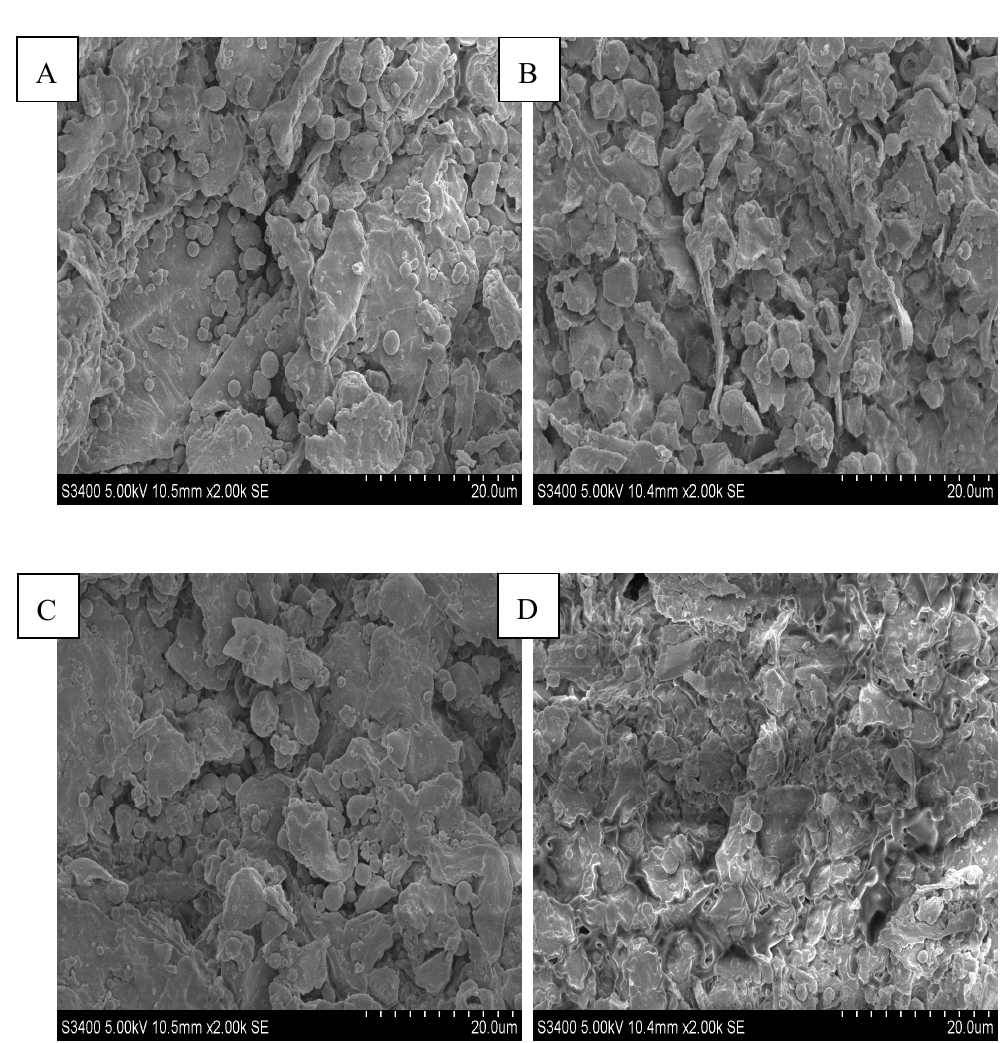
Figure 1. Scanning electron microscopy images of rice bran dietary fiber at different treatment stages ( A ) defatted rice bran, ( B ) rice bran dietary fiber, ( C ) cellulase enzymatic treatment rice bran dietary fiber, ( D ) high pressure treated rice bran dietary fiber.